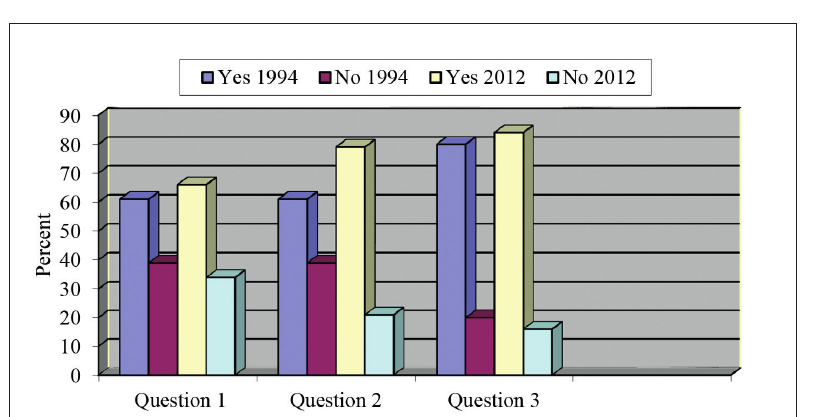
Figure 1. Responses to questions 1–3 in 1994 and 2012 (Summary of Tables 2, 3,